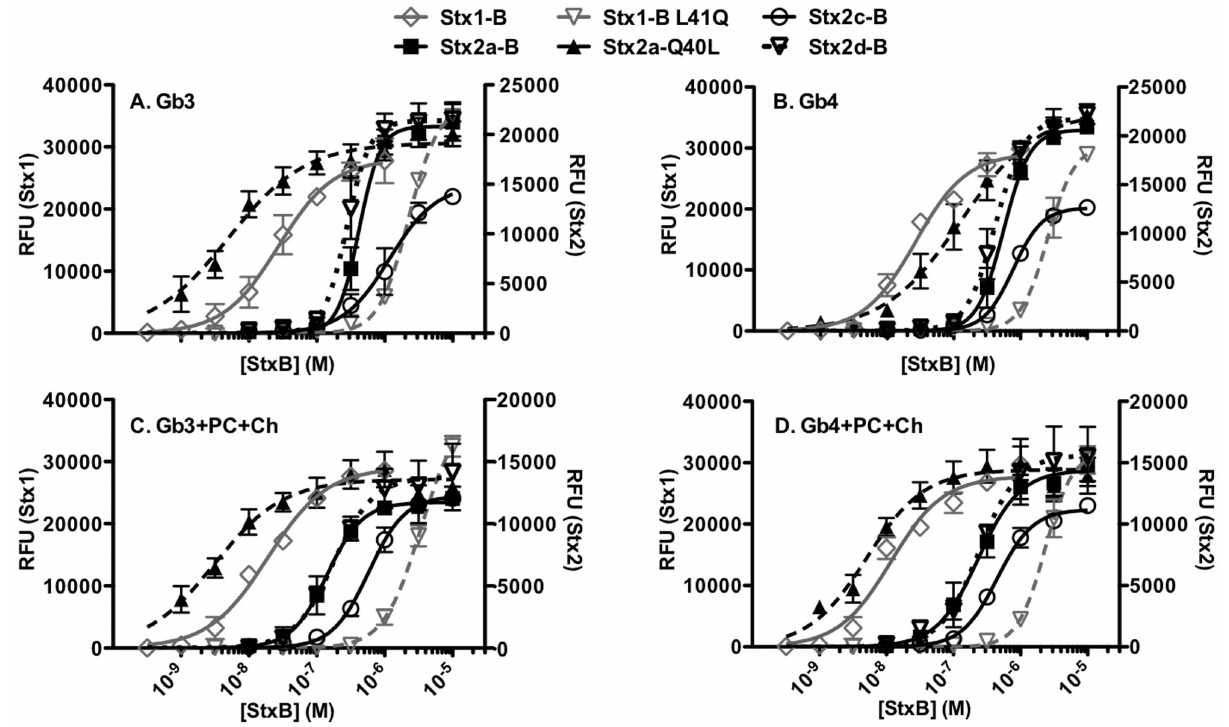
Figure 4. Glycolipid binding of Stx B-subunits. Serial dilutions of Stx B-subunits were titrated against immobilized glycolipids to obtain the dose response curves. A. Gb3, B. Gb3 + PC + Ch, C. Gb4, D. Gb4 + PC + Ch . B-subunits were incubated with methanol-coated wells as negative controls. Binding was assessed as described in Figure 2. The RFU signal is the mean of at least three independent experiments and error bars indicate SD. Symbols represent experimental data, while lines represent the fitted model for that data analyzed with Prism5 (GraphPad software, La Jolla,